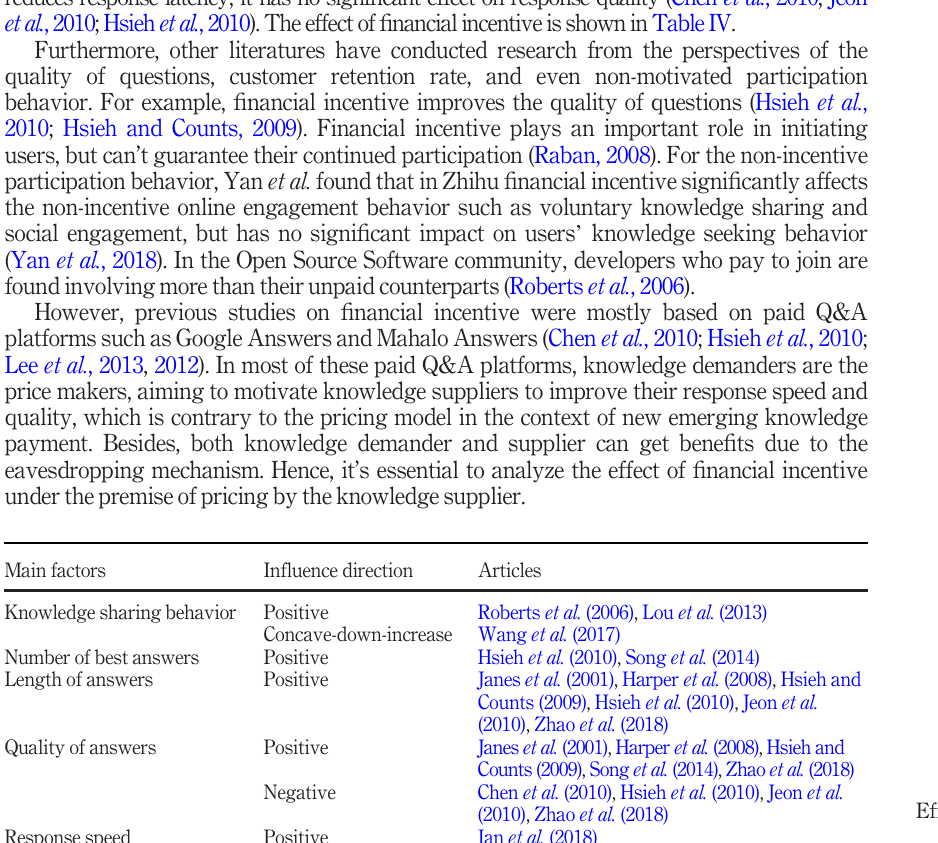
Table IV. Effect of fi